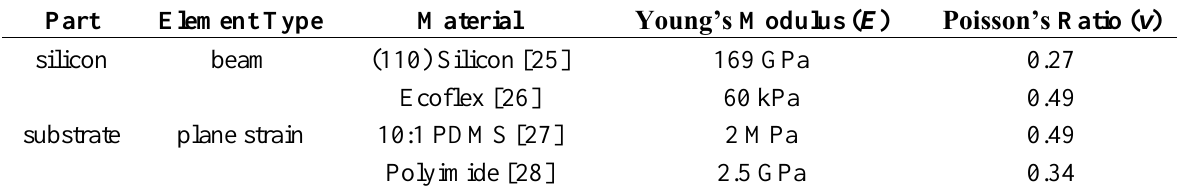
Table 1. Elastic properties of materials used in